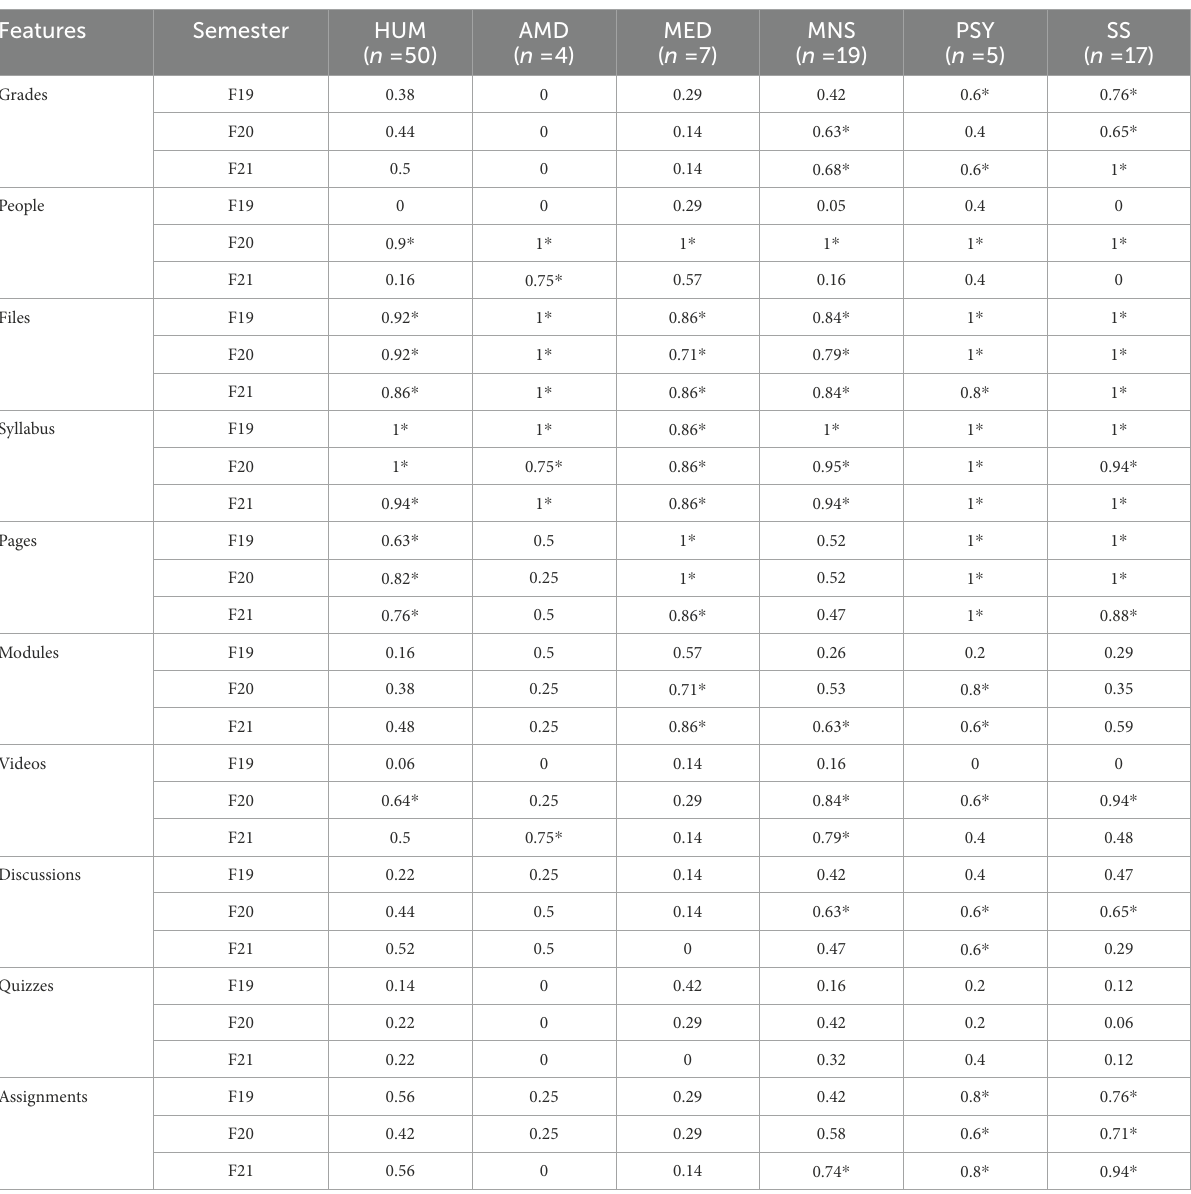
TABLE 7 Implementation rates of features per semester and